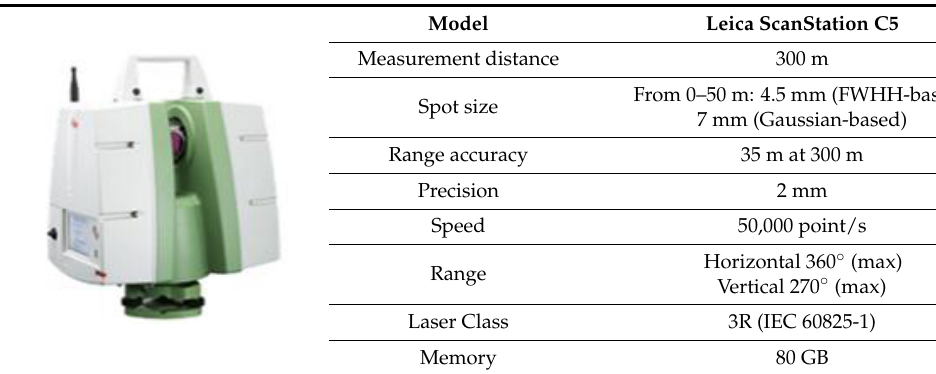
Table 3. Specifications of the terrestrial laser scanner.